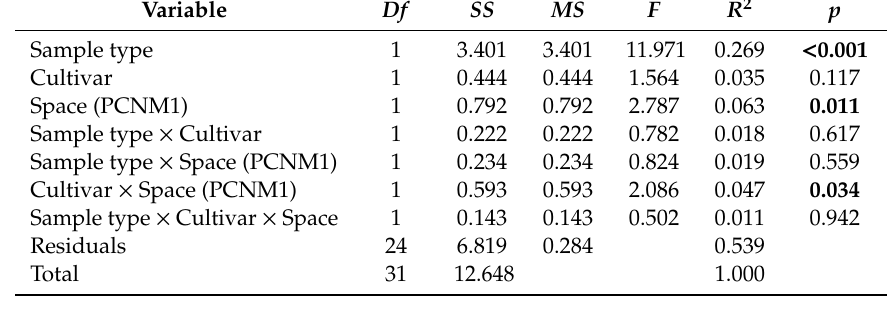
Table 2. E ff ect of sample type (soil vs. root), cultivar, spatial position (PCNM first axis), and their interactions with AM fungal community composition (permutational multivariate analysis of variance (PERMANOVA) 999 permutations and Euclidean distance as measure of dissimilarity). Bold values indicate significance.